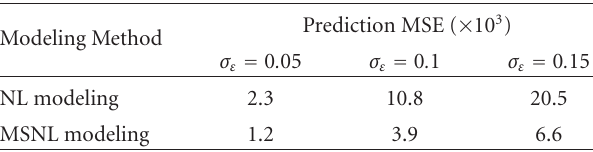
Table 1: Comparison between the prediction means square errors of the multiscale and time-domain modeling methods.